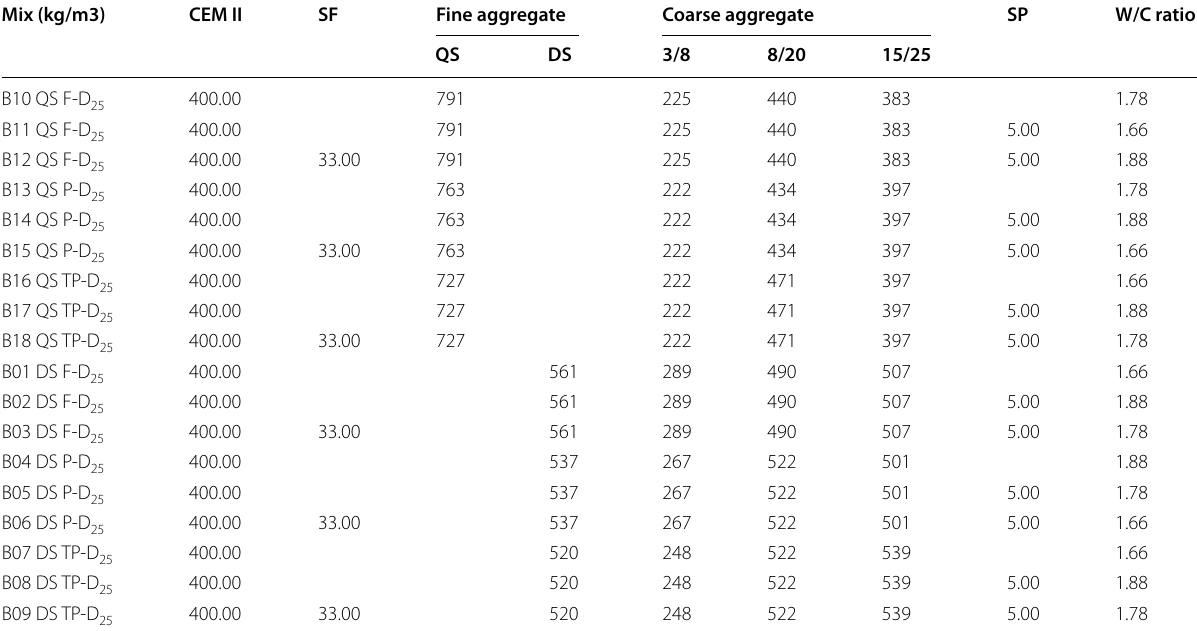
Table 4 Mixture proportions of concrete D 25